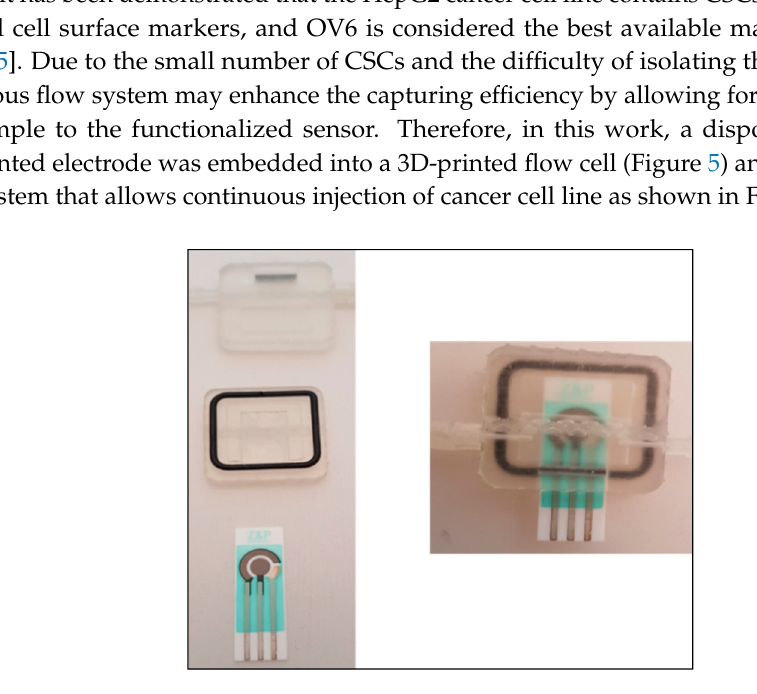
Figure 5. 3D-printed flow cell parts before and after hand-assembly with the functionalized electrochemical sensor. electrochemical